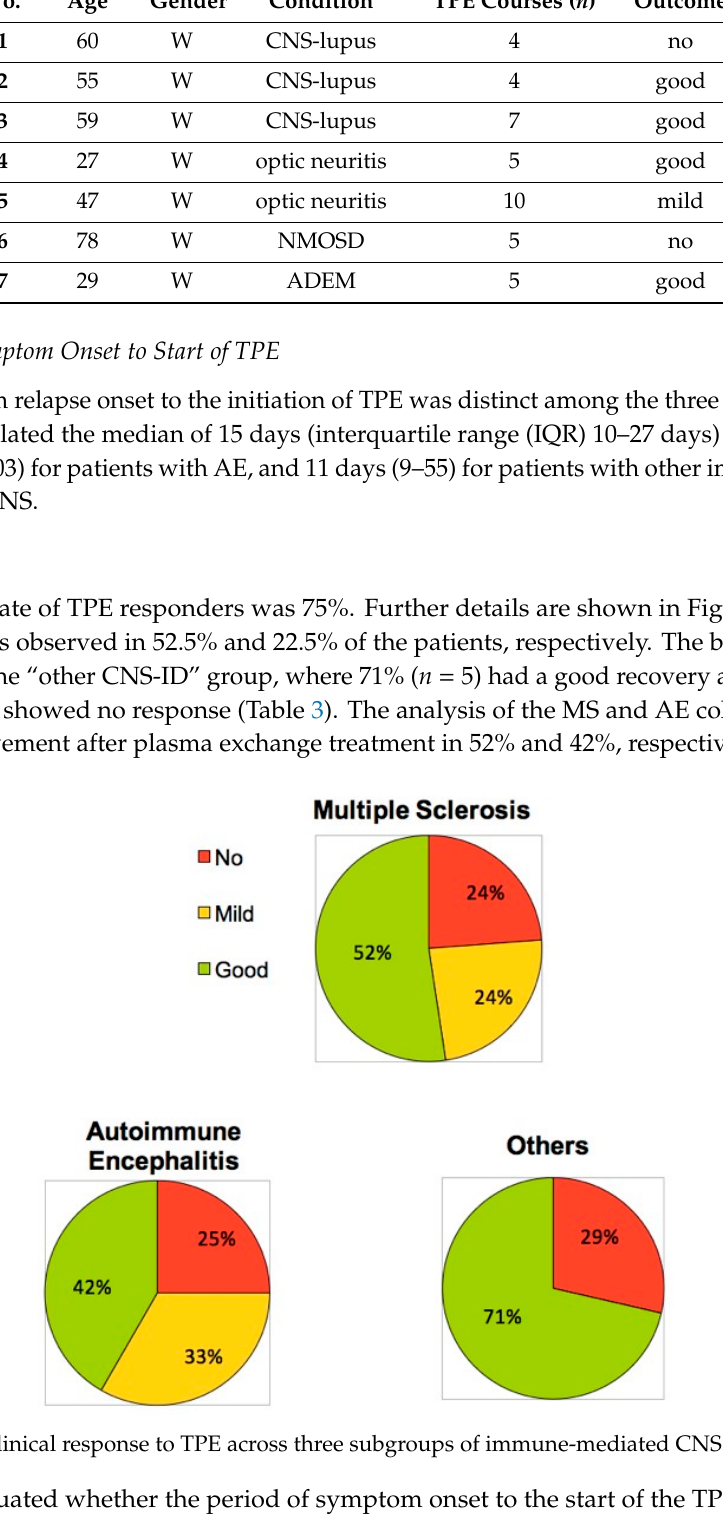
Table 3. TPE in patients with other immune-mediated disorders of the central nervous system (CNS).